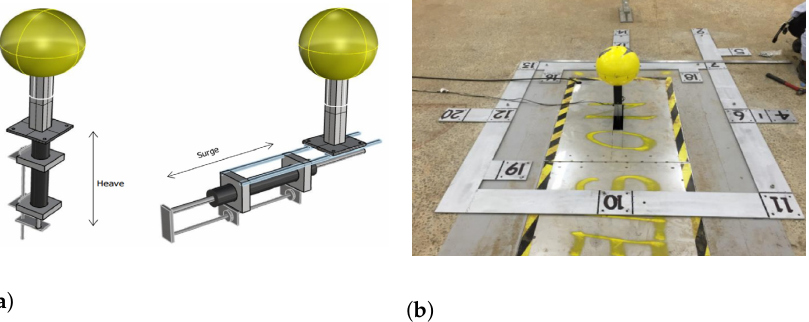
Figure 10. Experimental setup used by Nader et al., reprinted with permission from Ref. [9], 2017, Nadar et al.: ( a ) active WEC model; ( b ) frame and active WEC.